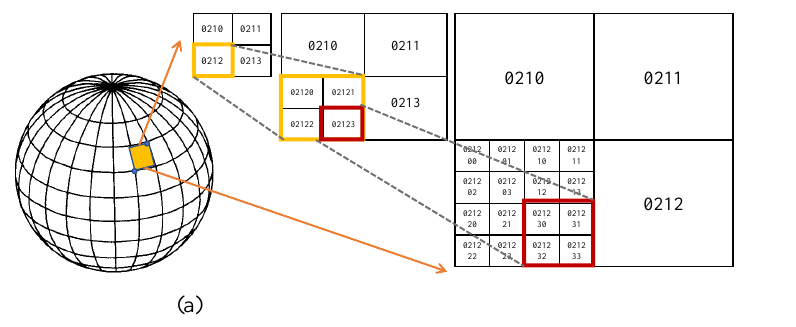
Figure 2. Spatiotemporal grid model, (a) Spatial grid coding, (b) Multi-scale coding representation of